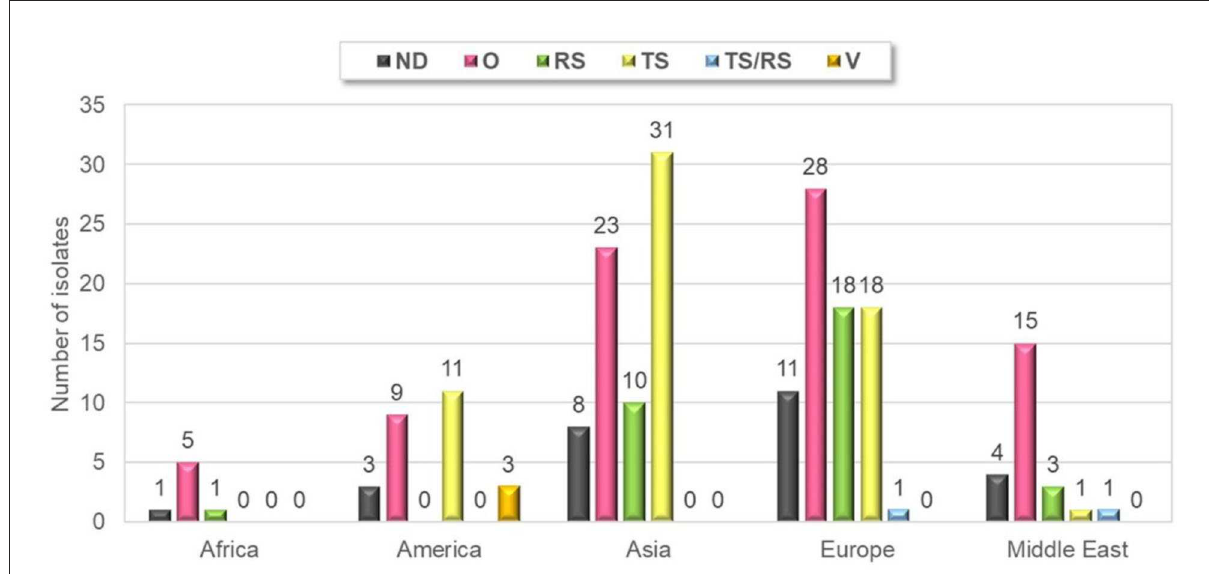
FIGURE2 Geographical distribution of different clinical manifestations of submissions. TS, tenosynovitis/arthritis; RS, runting-stunting syndrome; O, other; ND, not defined; V, vaccine.